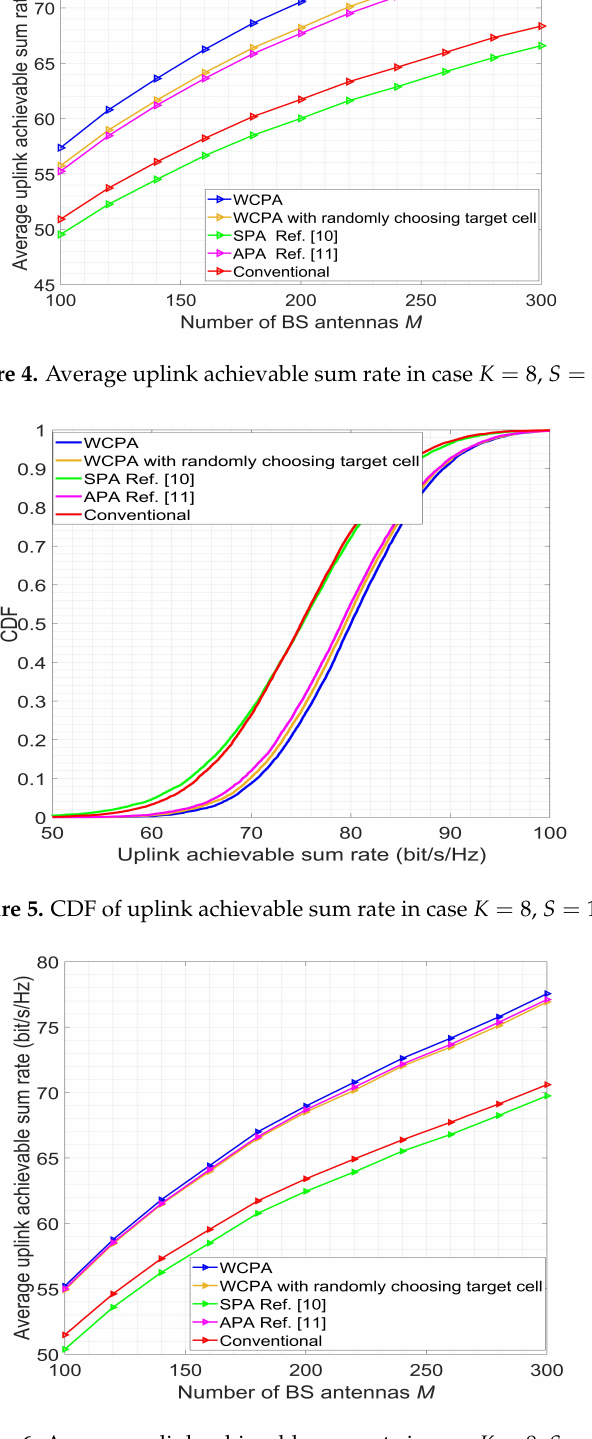
Figure 6. Average uplink achievable sum rate in case K = 8, S =